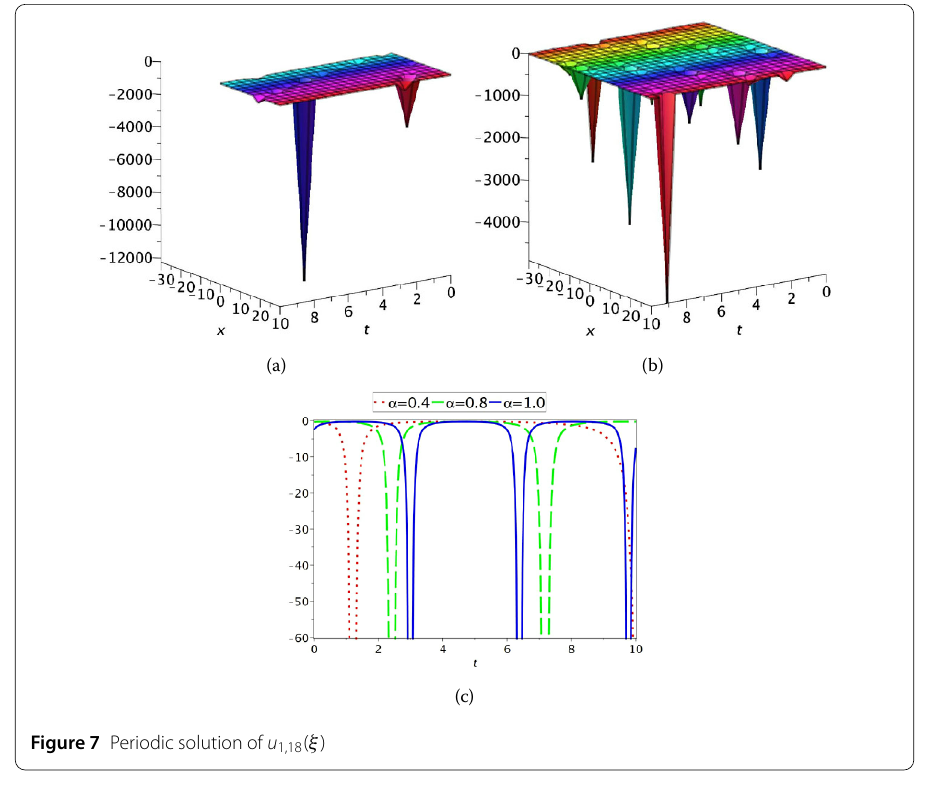
Figure 7 Periodic solution of u 1,18 ( ξ )